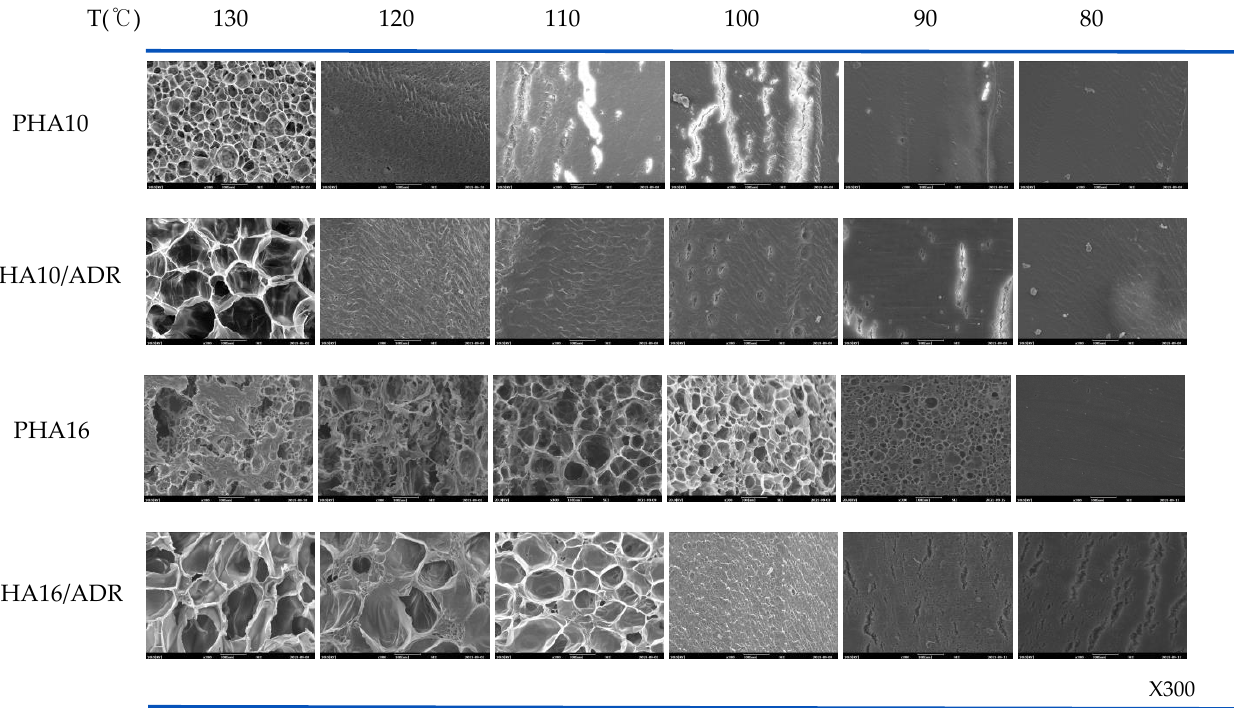
Figure 9. SEM micrographs of foamed crystalline P(3HB- co -4HB) with and without chain